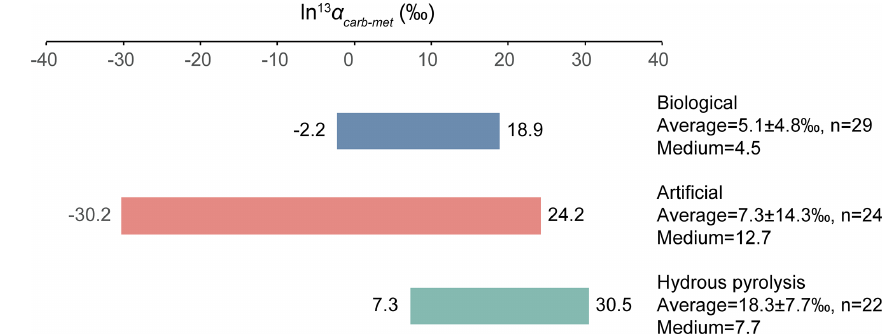
Figure 3. ln 13 α carb-met values of biological, artificial, and hydrous-pyrolysis-produced acetic acid.